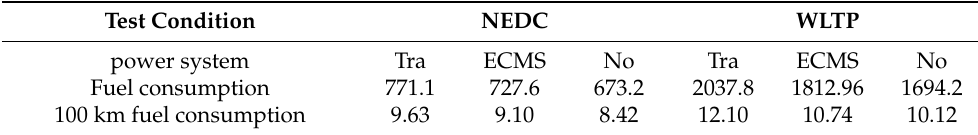
Figure 7. Comparison of fuel consumption of various power systems under different test conditions. ( a ) NEDV cycle test condition; ( b ) WLDP cycle test condition. Table 3. Comparison of fuel consumption under various power